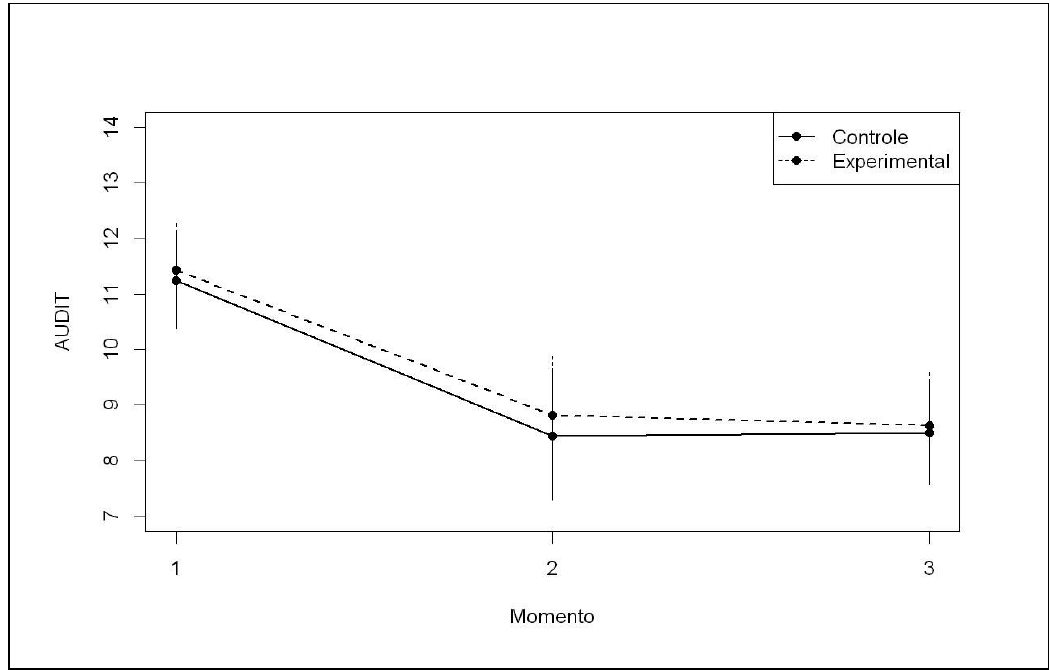
Figura 1 . Escore médio da variável AUDIT de acordo com o grupo (controle e experimental) e o momento de